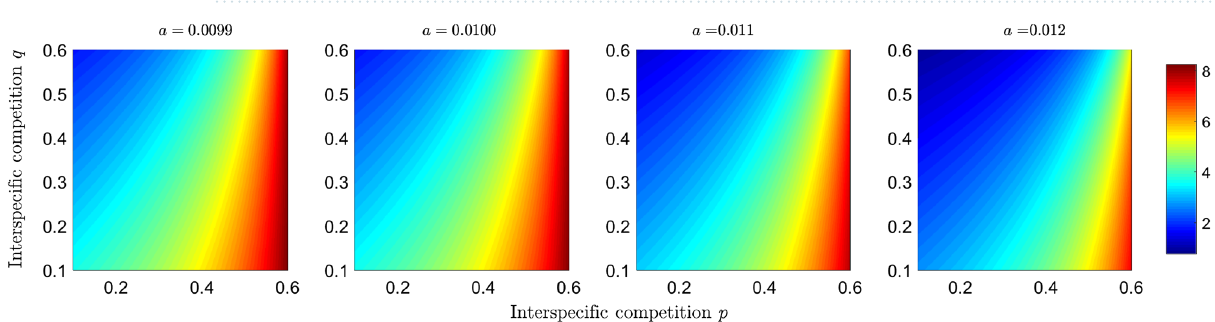
Figure 4. Simulation of the infected population of the predator at equilibrium as a function of the competition parameters p and q under different scenarios of predation efficiency a , where ( q , p ) ∈ [ 0.1, 0.6 ] × [ 0.1, 0.6 ] . The colored bar represents the number of infected individuals.